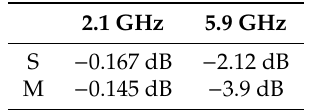
Figure 6. Simulated and measured radiation patterns: ( a ) H-plane patterns at 5.9 GHz; ( b ) E-plane patterns at 5.9 GHz; ( c ) H-plane patterns at 2.1 GHz; ( d ) E-plane patterns at 2.1 GHz. Table 4. Simulated (S) and Measured (M) Peak